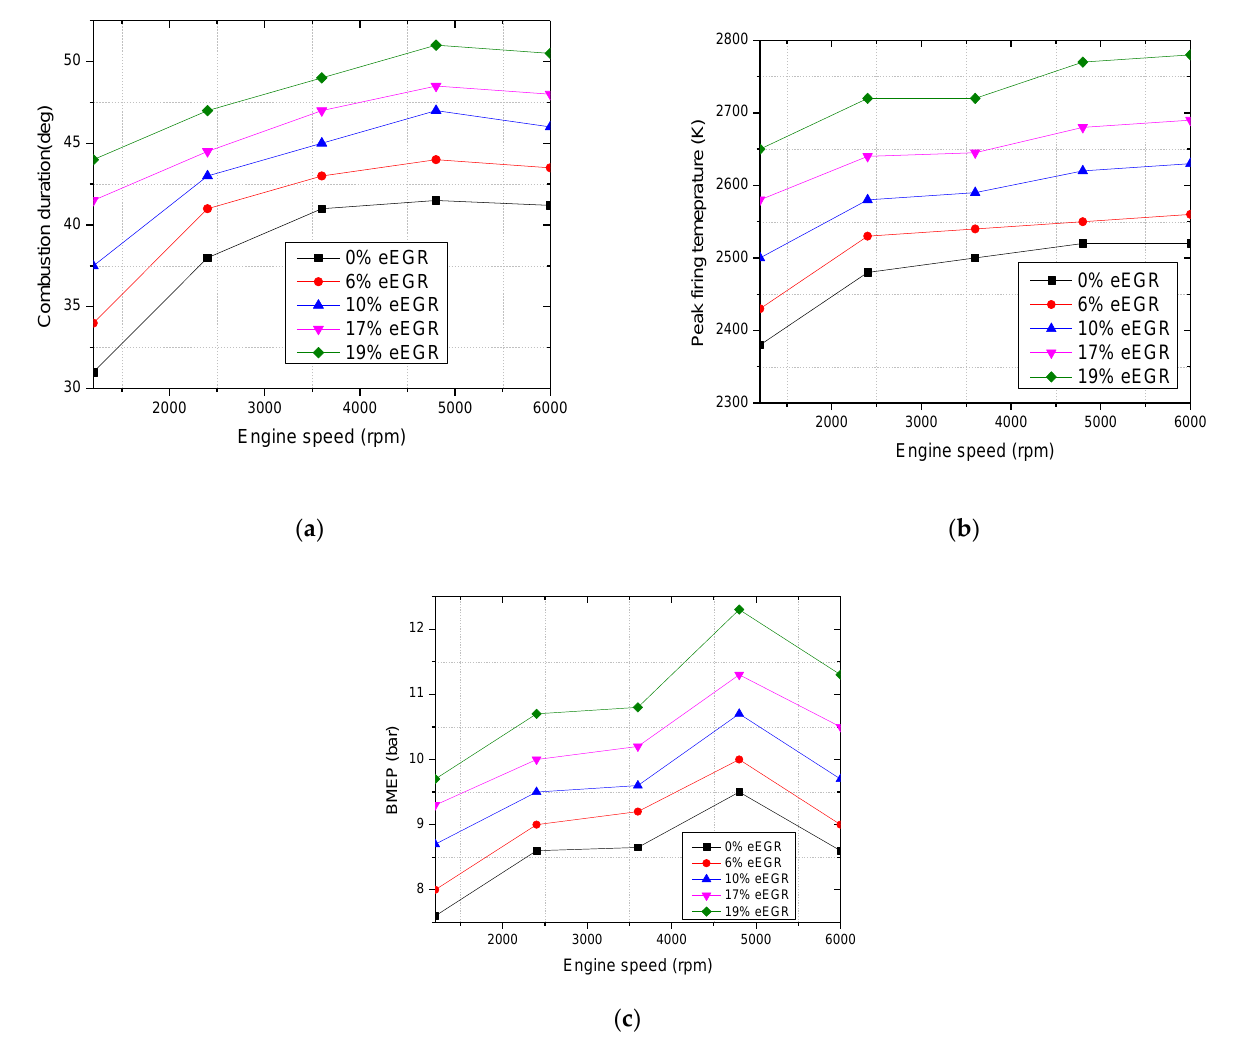
Figure 9. The effect of eEGR on: ( a ) combustion at various engine speeds; ( b ) peak temperature at various engine speeds; ( c ) BMEP and BSFC at various engine speeds. A reduction of NO x and CO emissions and increase in hydrocarbons is reported.